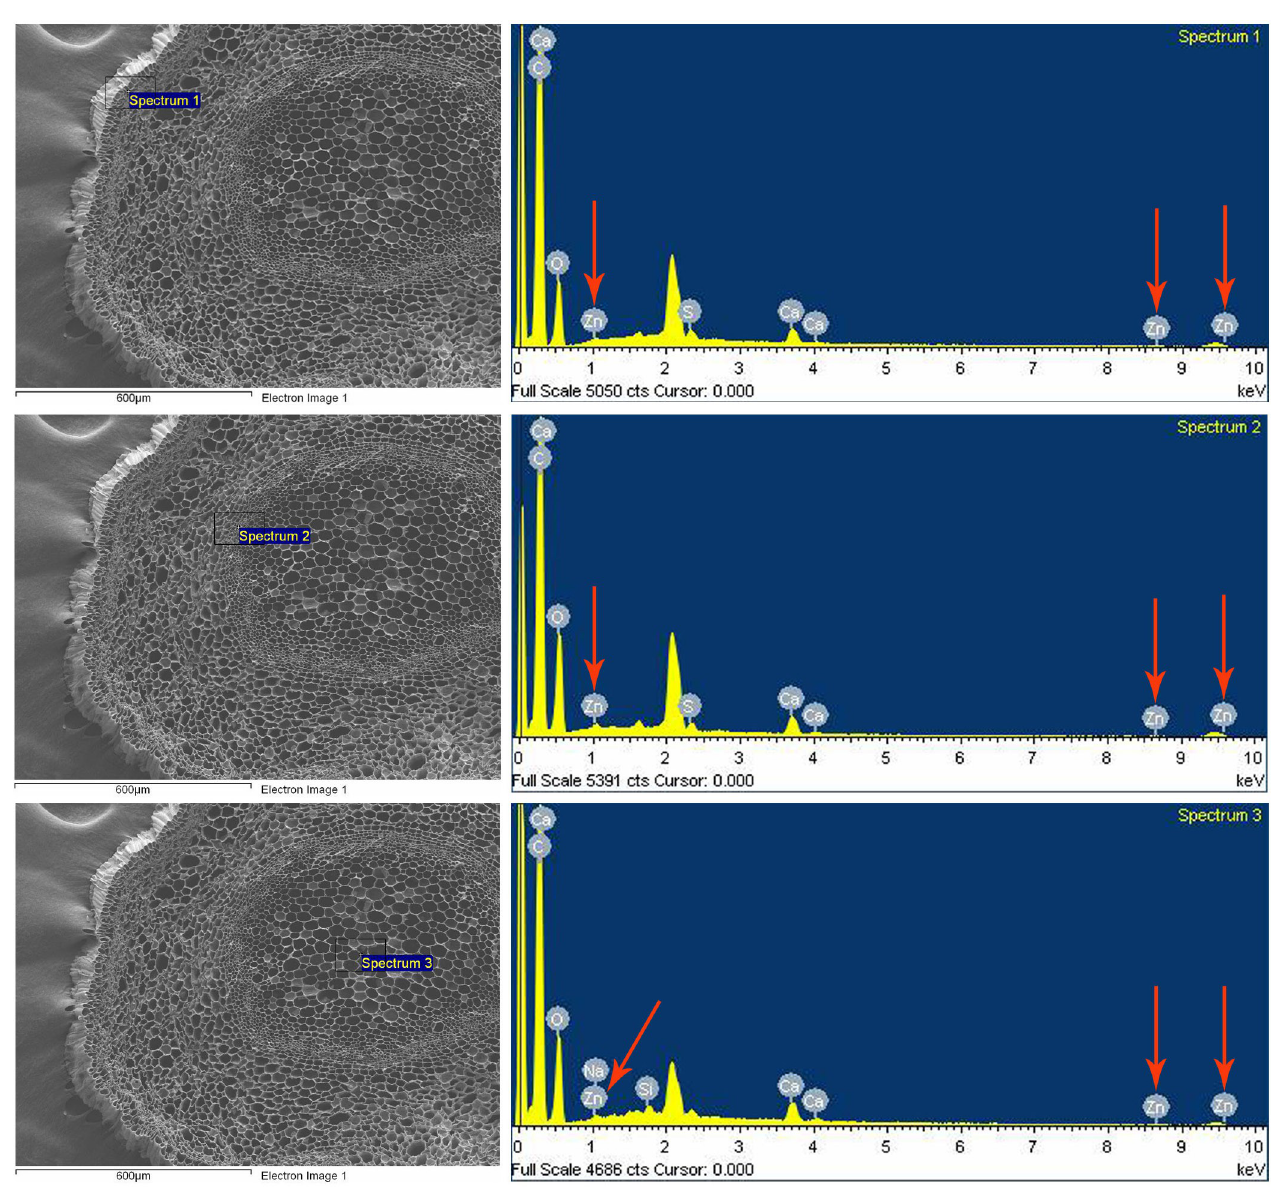
Fig 4. FEG SEM-EDXM of A . ilicifolius L. control roots. The SEM and EDX of three areas of root, spectrum 1 (exodermis and cortex), spectrum 2 (endodermis and vascular tissues) and spectrum 3 (pith).